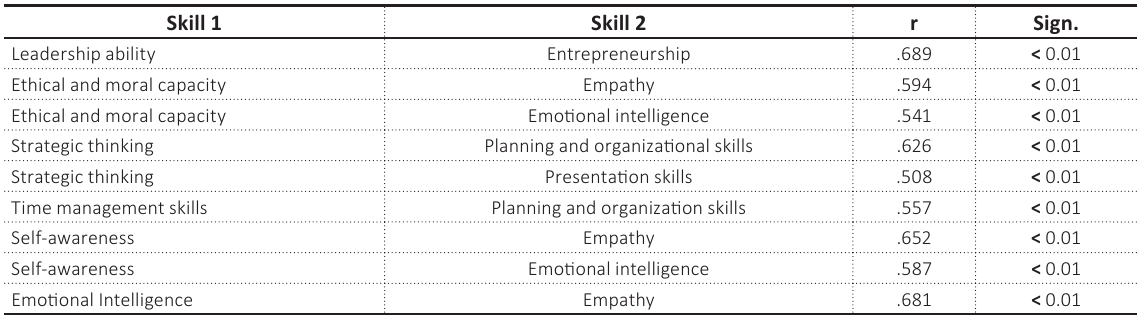
Table 4. Relationships between soft skill expectations and their closeness Source: Own